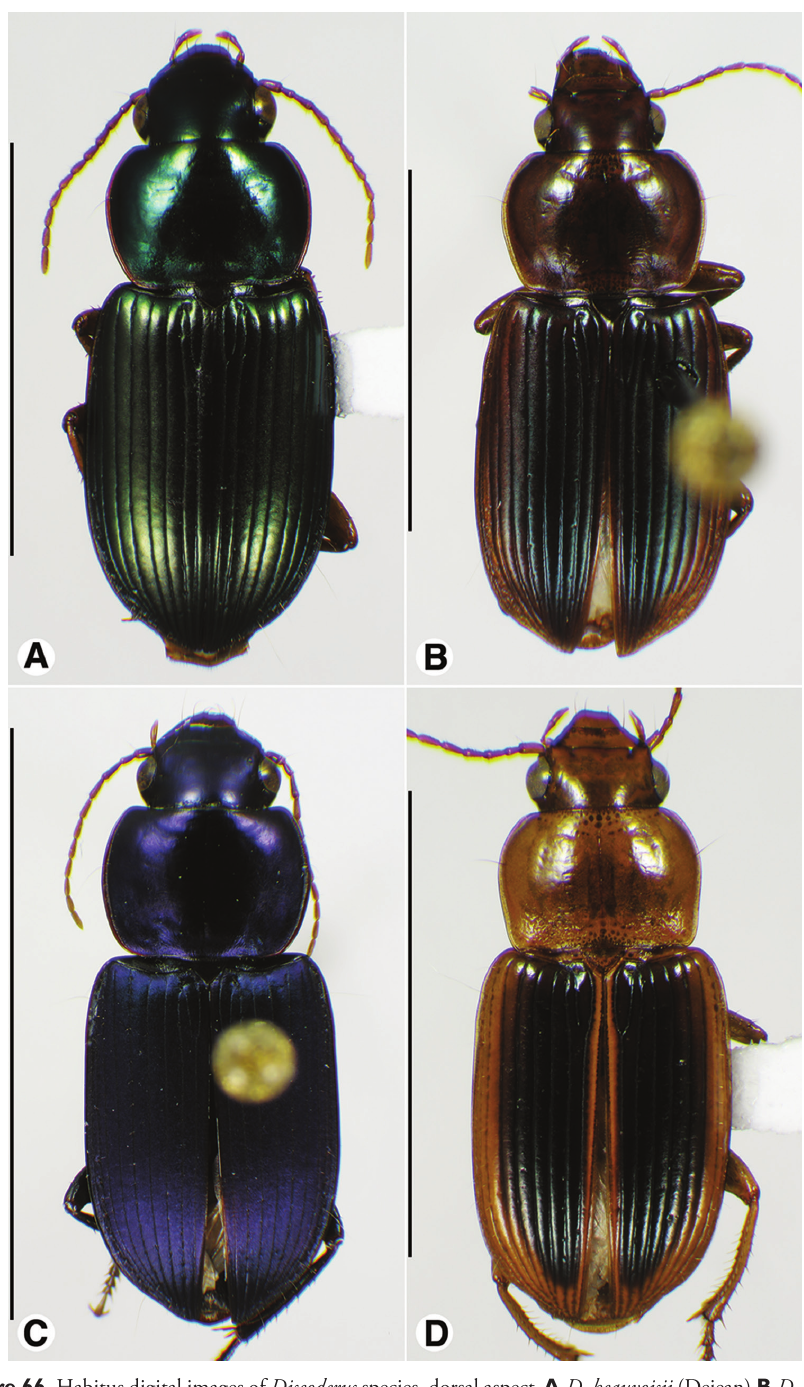
Figure 66. Habitus digital images of Discoderus species, dorsal aspect. A D. beauvoisii (Dejean) B D. cinctus (Putzeys) C D. cyaneopacus (Darlington) D D. thoracicus (Putzeys). Scale bars: A, B, D 5 mm; C 10